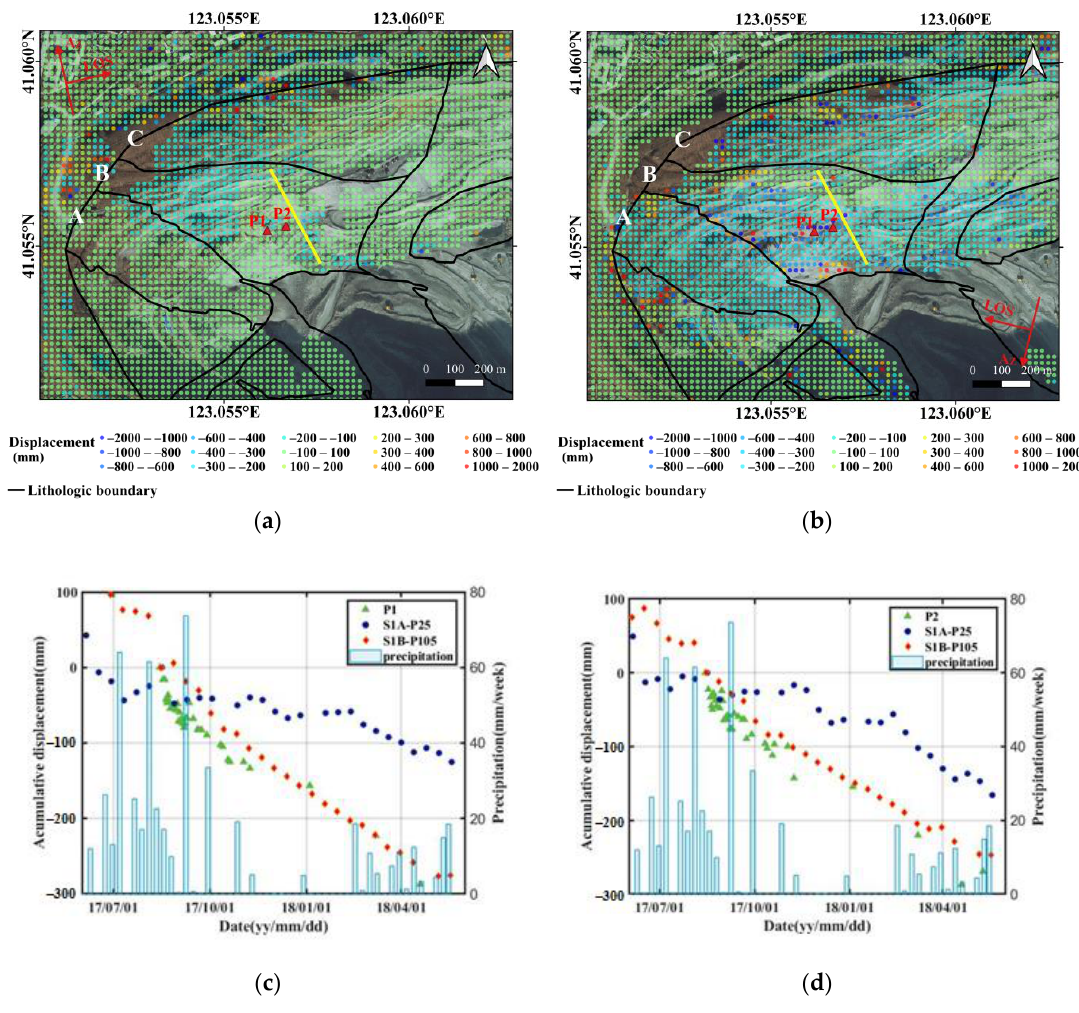
Figure 10. Cumulative displacement along slope direction in ascending ( a ) and descending ( b ) orbits, and slope displacement time series of ground measurement points P1 ( c ) and P2 ( d ). Table 2. Root mean square error (RMSE) of slope displacements on P1 and P2, with reference to ground measurements